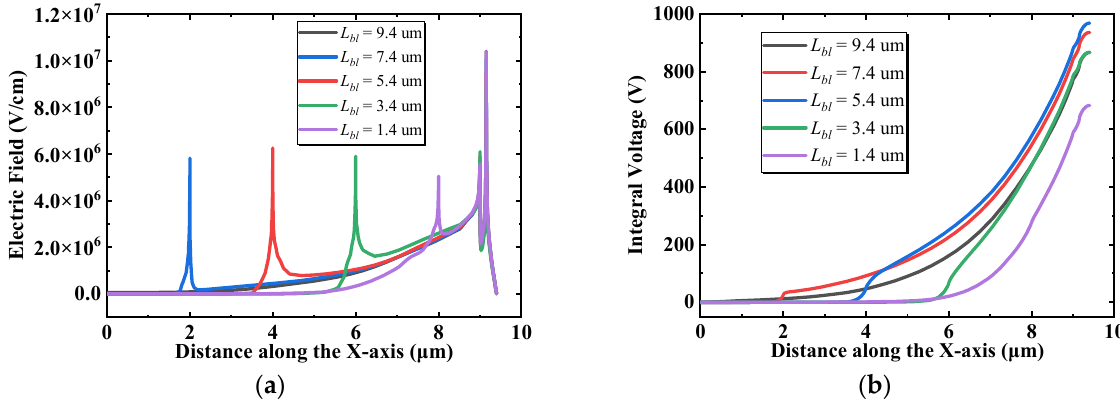
Figure 7. ( a ) The off-state lateral electric field distribution with different L bl . ( b ) The integral of the electric field along the X -axis with different L bl .